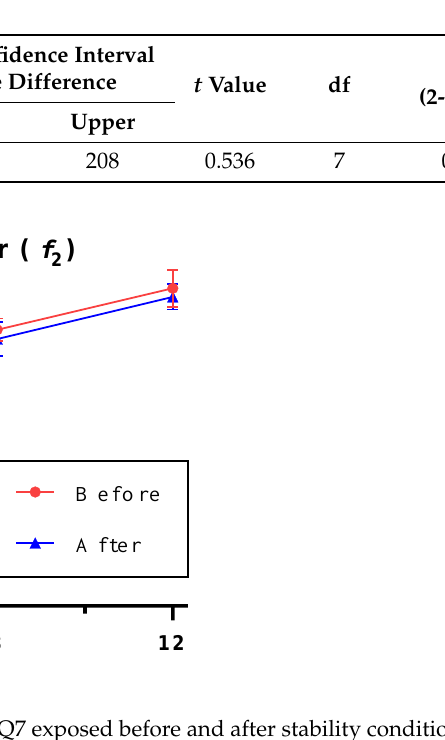
Table 6. Outcome of the Student’s t-test for Q7 formulation exposed before and after stability conditions.